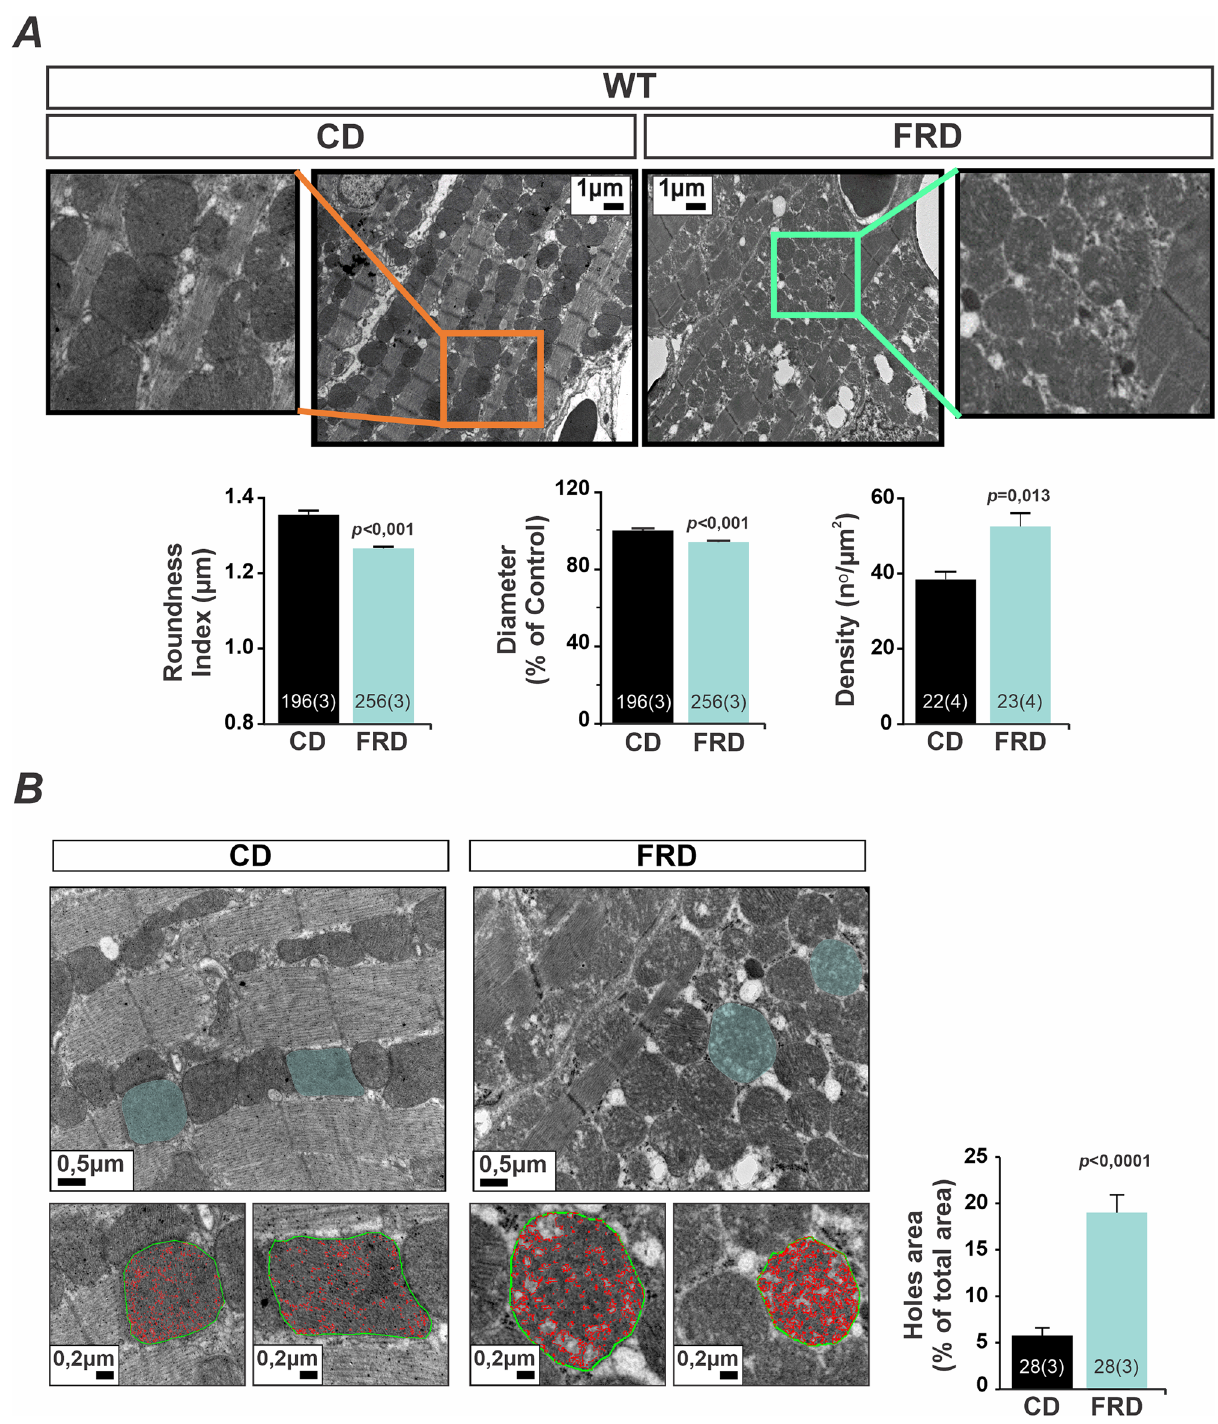
Figure 4. Mitochondria morphology and density are altered in prediabetic mouse hearts. ( A ) Representative transmission electron microscopy (TEM) photographs from cardiac tissue and average bar graphs of mitochondria morphology parameters (Roundness and Diameter) and mitochondria density. FRD WT presents a decrease in diameter and an increased roundness and density with respect to CD WT specimens. ( B ) Representative TEM photographs of hearts from CD and FRD treated mice, showing the analysis developed to measure the area of holes in the mitochondria selected (light blue area). The magnified photographs below show the skeletonized mitochondria (green line) and the holes area (red line). The bar graph shows the average of holes area normalized by the entire mitochondria area. The mitochondria from FRD WT present increased holes area with respect to CD WT mice